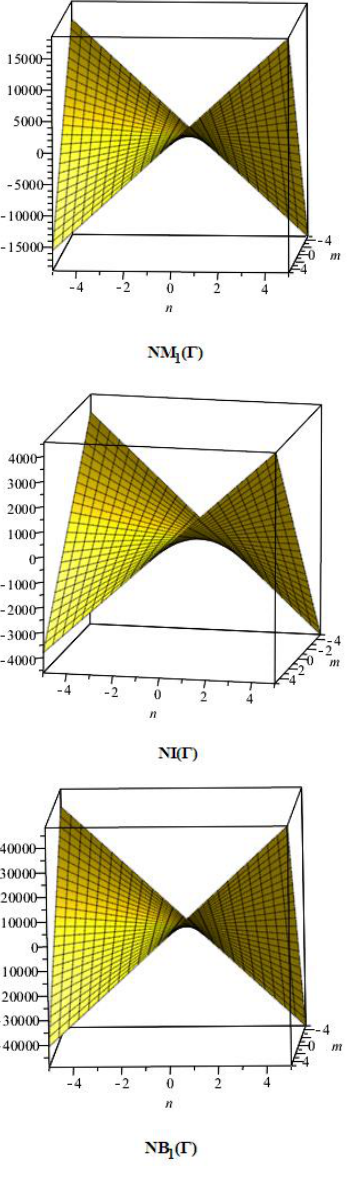
Figure 14. 3D plots for theorem 8. Table 16. Comparison Table for Theorem